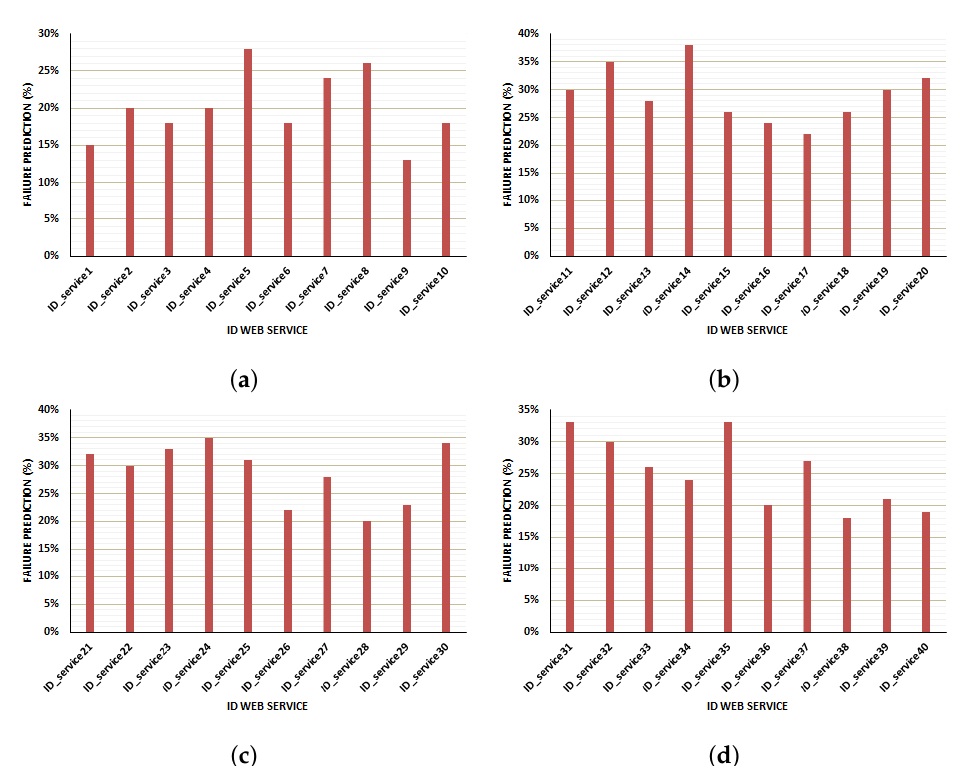
Figure 6. The prediction algorithm evaluation results in terms of failure prediction ratio. ( a ) web service 1–10; ( b ) web service 11–20; ( c ) web service 21–30; ( d ) web service